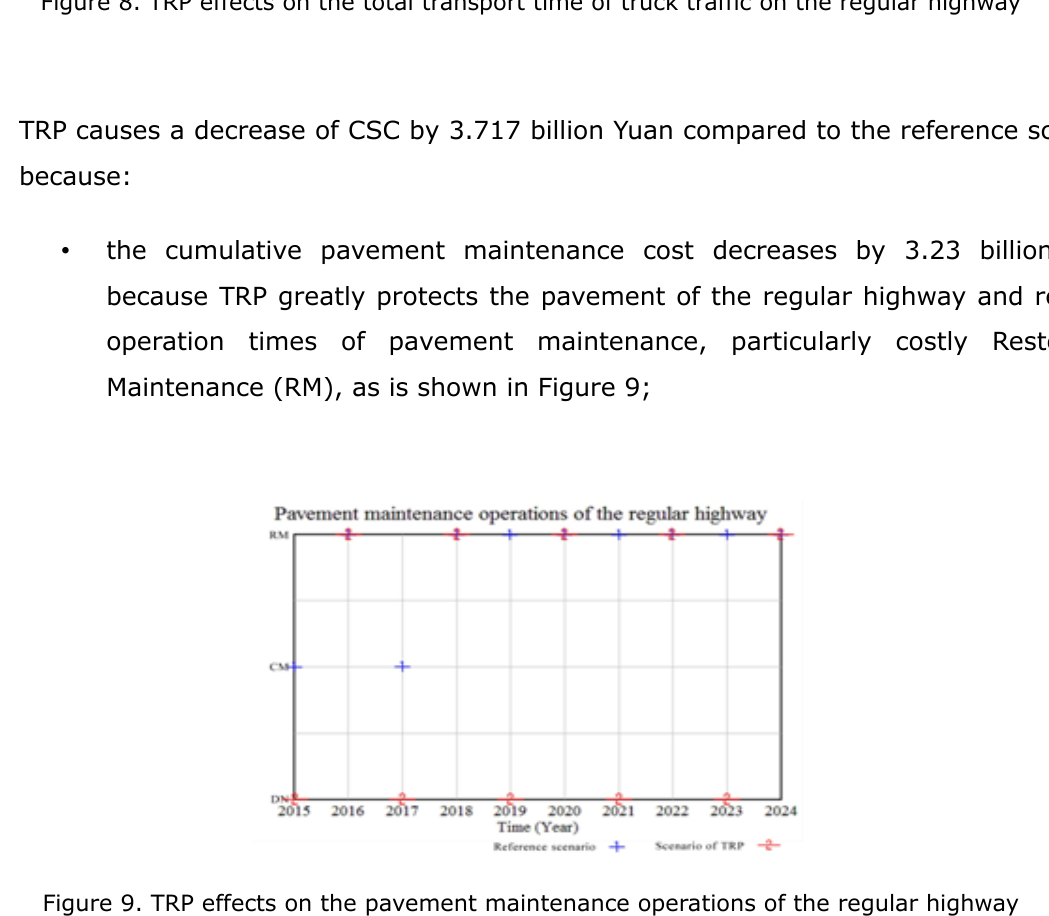
Figure 9. TRP effects on the pavement maintenance operations of the regular